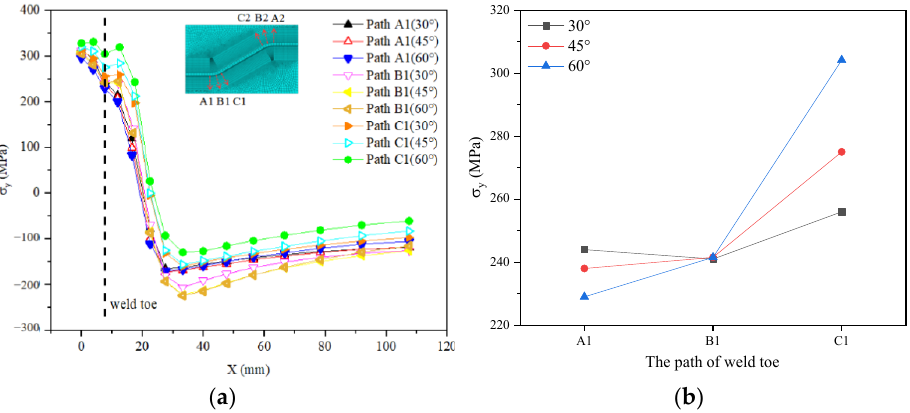
Figure 21. Residual stress distribution of longitudinal path posterior weldment. ( a ) Along the path direction; ( b ) Position of weld toe.